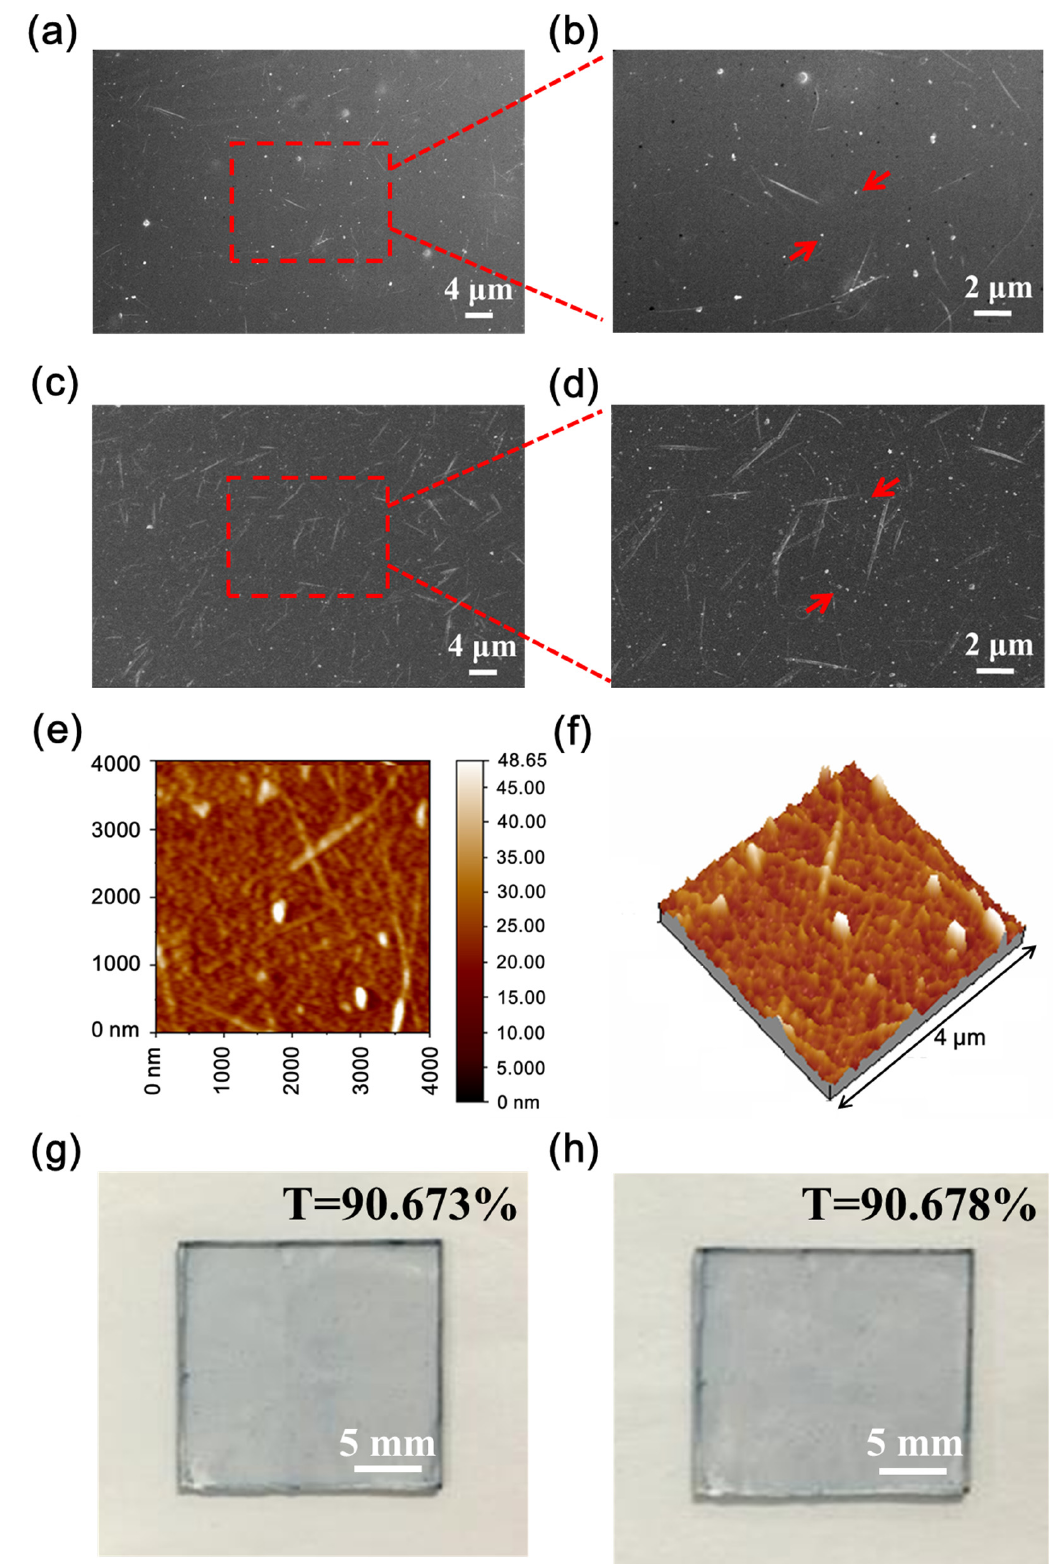
Figure 3. ( a–d ) SEM images of: ( a ) CNT/P-NTCFs prepared from a CNT solution of 0.2 mg/mL and ( b ) an enlarged image of the boxed region in ( a ); ( c ) CNT/P-NTCFs prepared from a CNT solution of 1.0 mg/mL and ( d ) an enlarged image of the central part in ( c ). ( e,f ) The AFM micrograph: ( e ) a topographic image and ( f ) the corresponding three dimensional image of the CNT/P-NTCF. Pictures of CNT/P-NTCF: ( g ) before and ( h ) after the adhesion test.